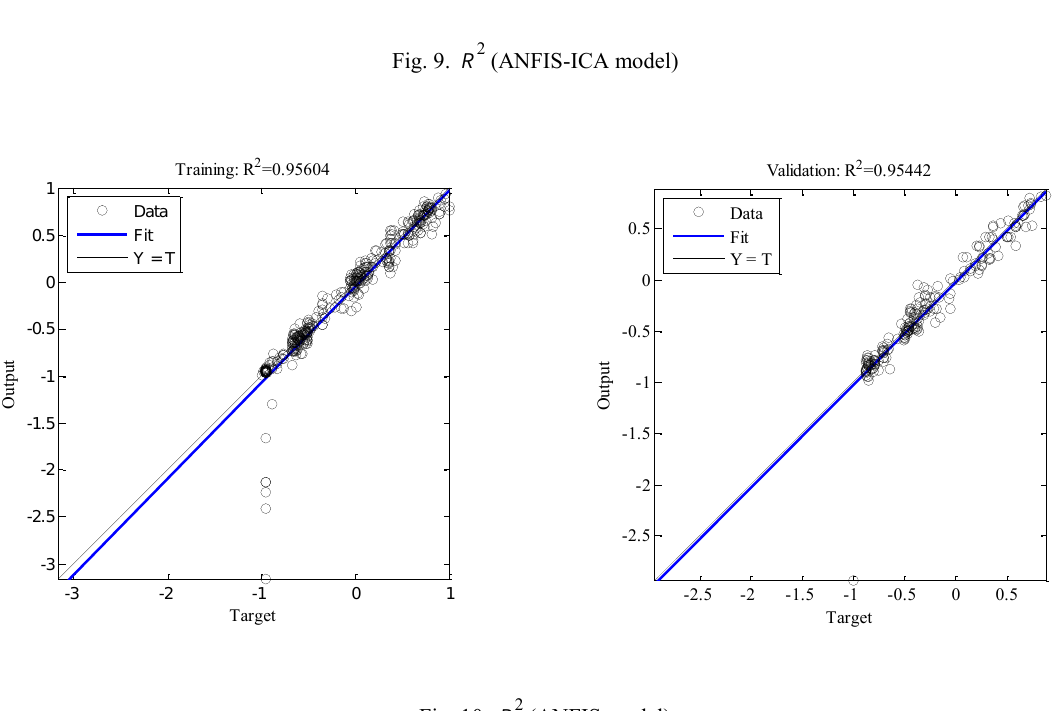
2 R (ANFIS model) TABEL 1. Comparison between the performances of ANFIS-ICA model and ANFIS